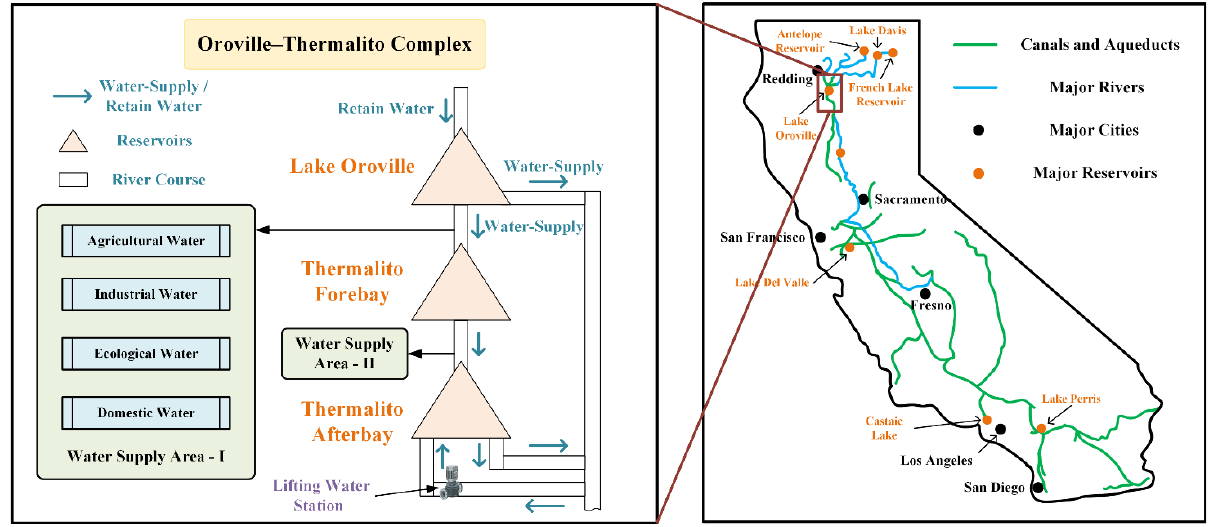
Figure 2. Topological structure diagram of cascade reservoir system in the Oroville–Thermalito Complex.